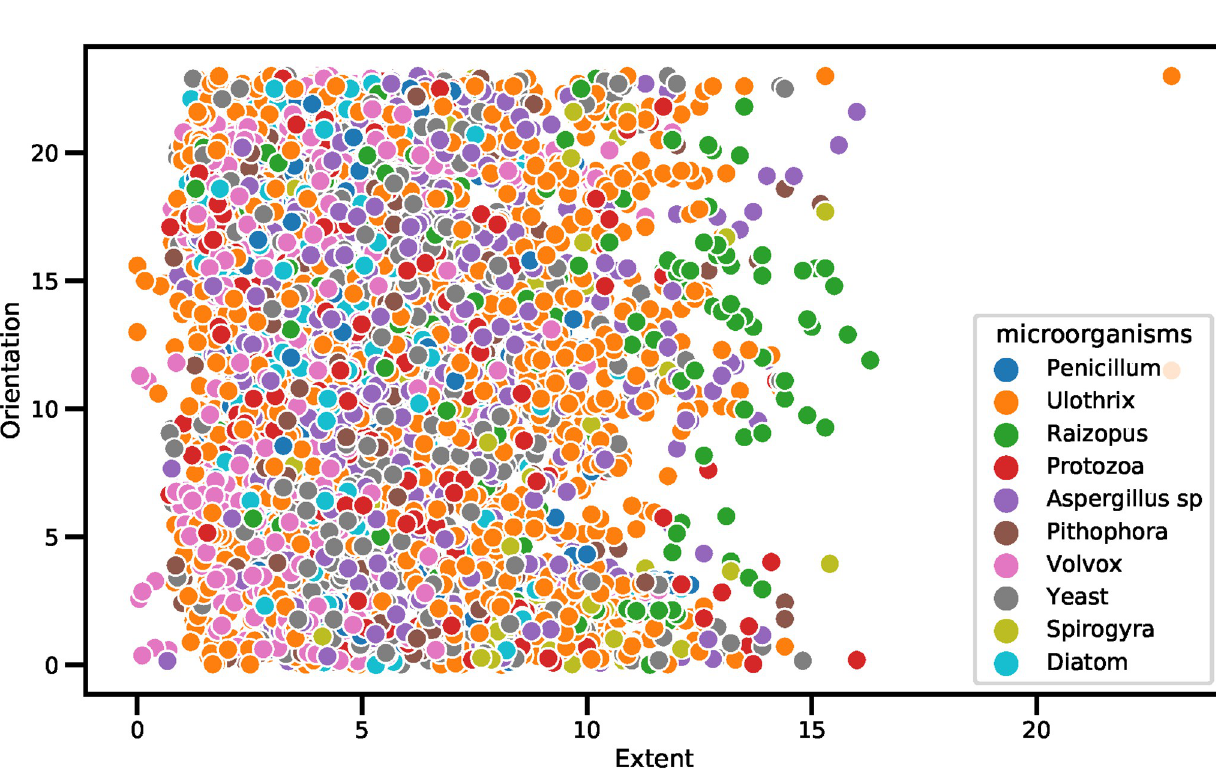
Fig 5. The scatter showing the distribution of features regarding Extent and Orientation along with the target class. https://doi.org/10.1371/journal.pone.0284522.g005 PLOS ONE | https://doi.org/10.1371/journal.pone.0284522 April 20,